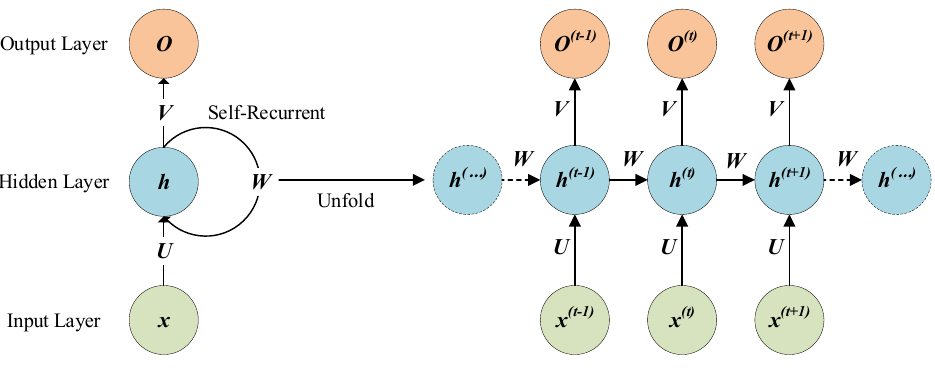
Figure 1. RNN architecture.